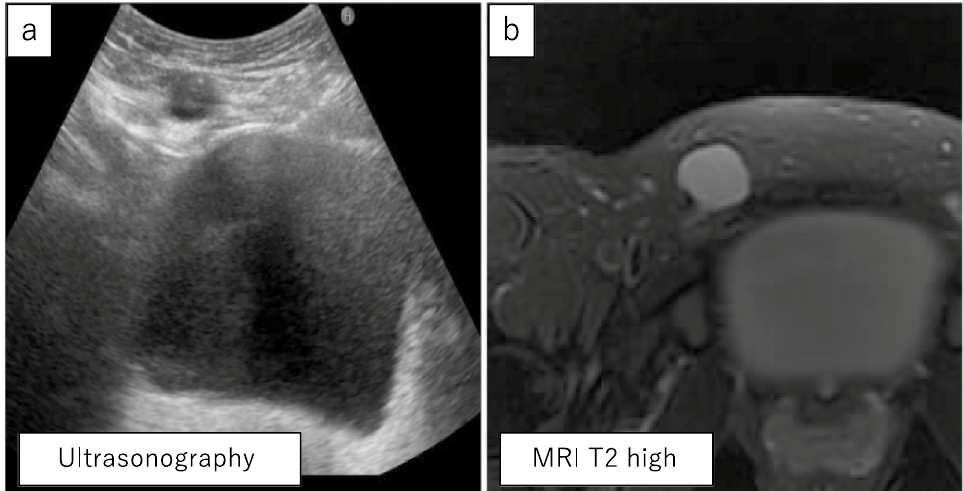
Fig. 1 a Ultrasonography showed 3.0 T2‑weighted imaging in her right inguinal